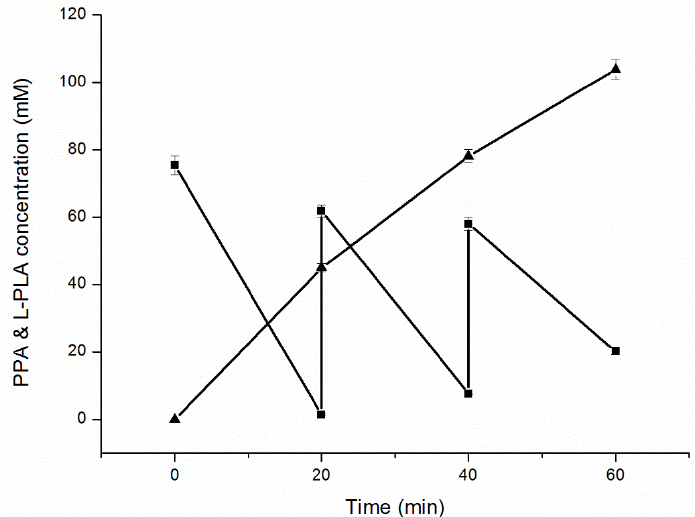
Figure 5. Time course of l-PLA production in fed-batch bioconversion with intermittent substrate feeding. ( ■ ) Concentration of PPA; ( ▲ ) Concentration of l-PLA.